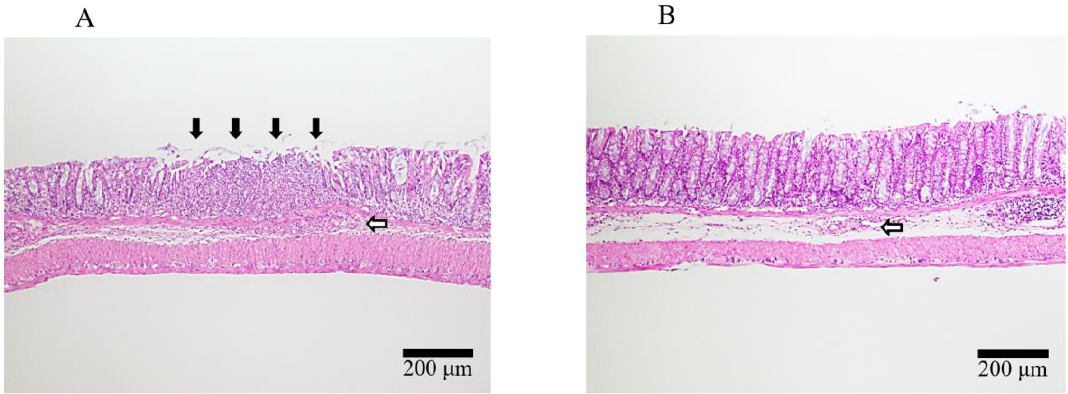
Figure 7. Histology of control group mice ( A ) and 20kPEG-AM-treated mice ( B ). Figure 7A shows focal ulceration (black arrow) with mucosal and submucosal immune cell infiltration (white arrow). Figure 7B shows no architectural change with mild inflammatory cell infiltrates in the submucosa (white arrow). The scoring of the histomorphological evaluation showed no statistically significant differences.